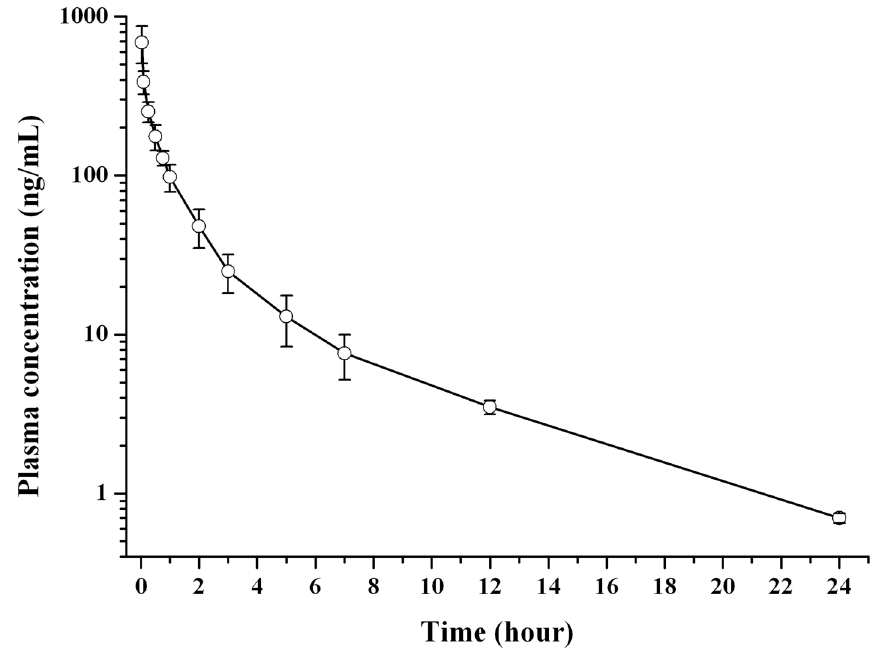
Fig 6. Mean plasma drug concentration-time curve of nalmefene in rats following the single subcutaneous injection of drug solution in rats (n = 6).